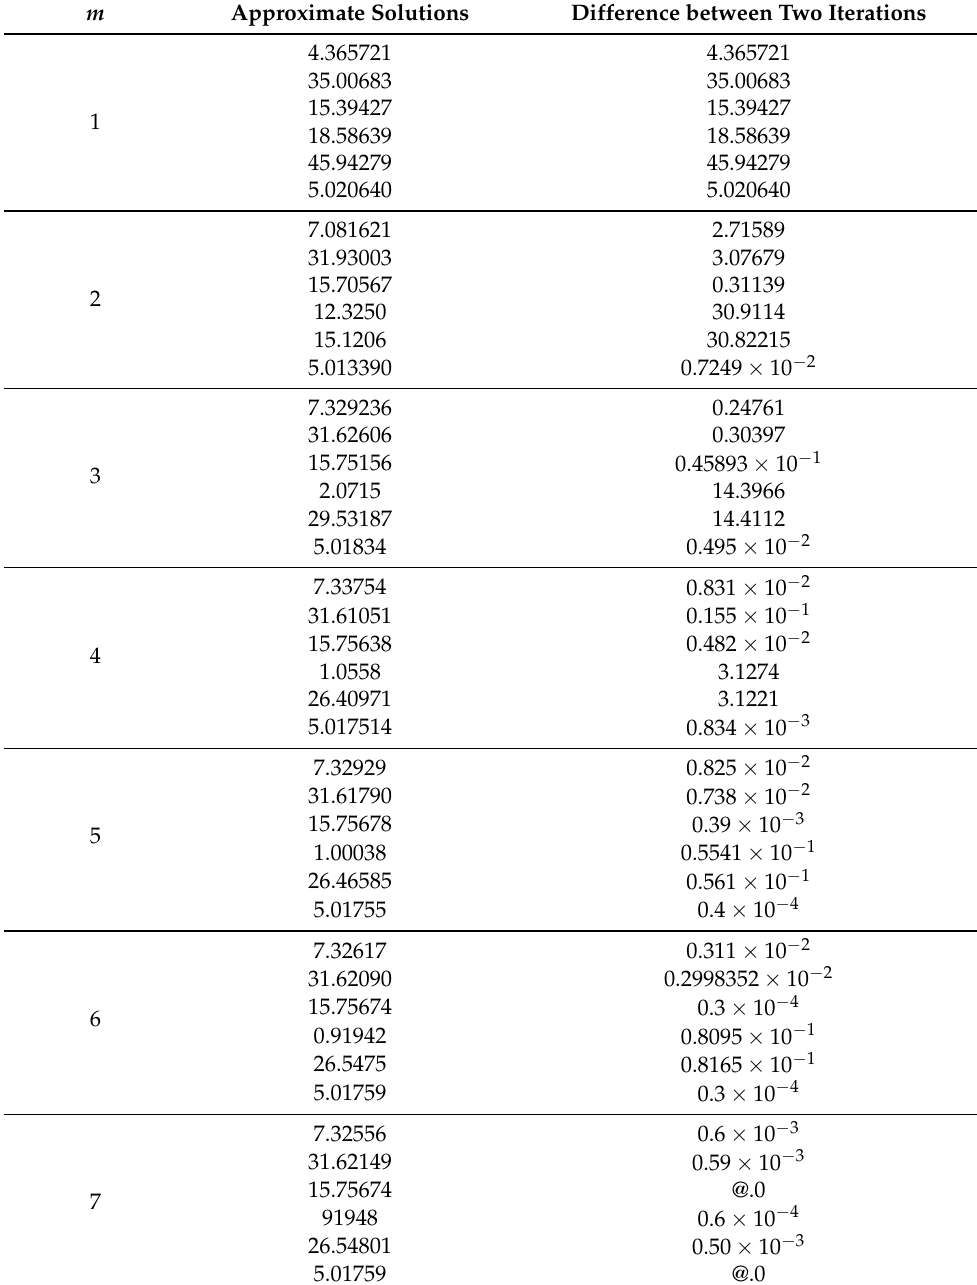
Table 2. Numerical results based on the DSA and using the CESTAC method for t = 0.2, ρ = 1 and ¯ h = −